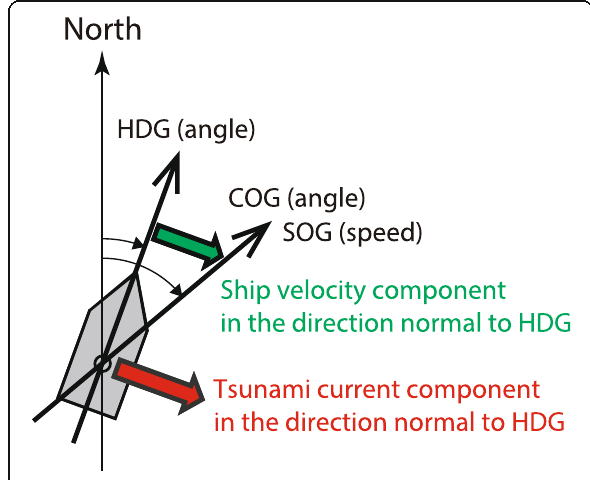
Fig. 3 Schematic of speed over ground (SOG), course over ground (COG), heading (HDG), and HDG-normal components of ship velocity and tsunami